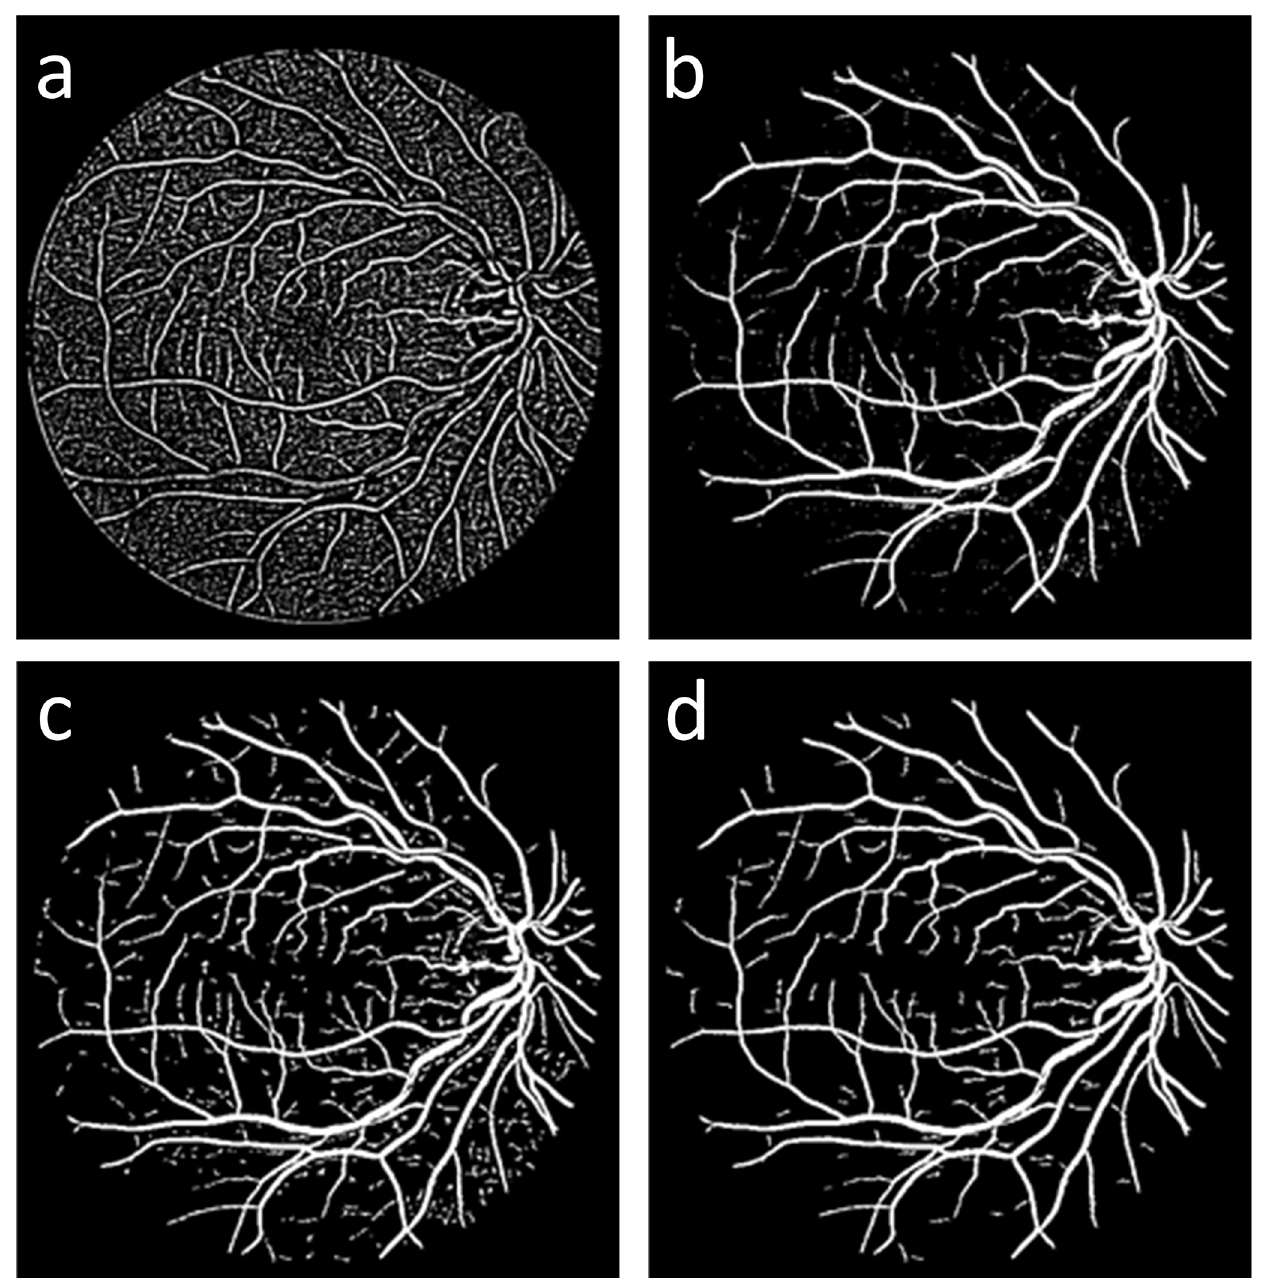
Fig 5. Complementation process output: (a) the binary image I com , (b) the main vessel structure I GMM , (c) the result of vessel complementing I C − GMM , and (d) the final outcome of the proposed method I FINAL .